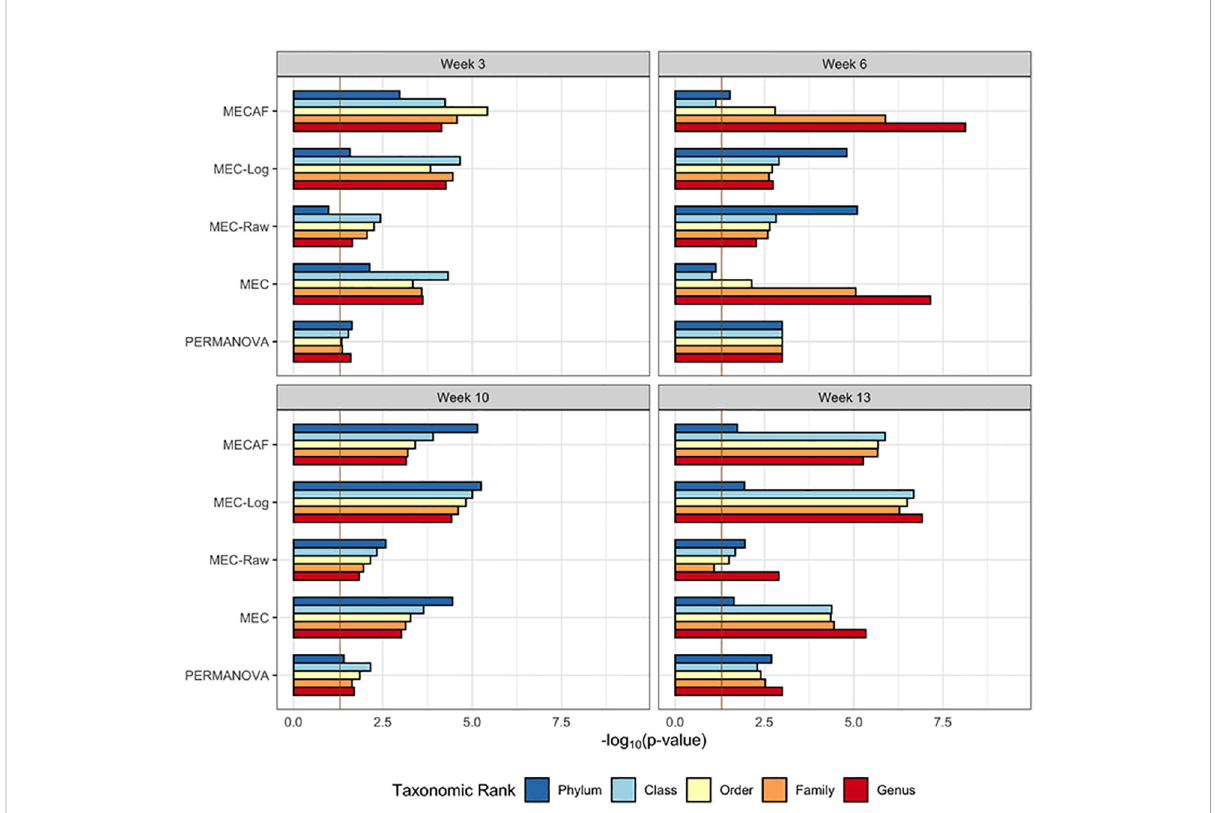
FIGURE 6 DA analysis in male mice of the murine microbiome study. p-Values of DA test with MECAF and competing methods at four assessed time points are shown. p-Values were – log 10 transformed to better illustrate the statistical signi fi cance where the vertical line of -log 10 0.05 indicates the signi fi cance level. DA, differential